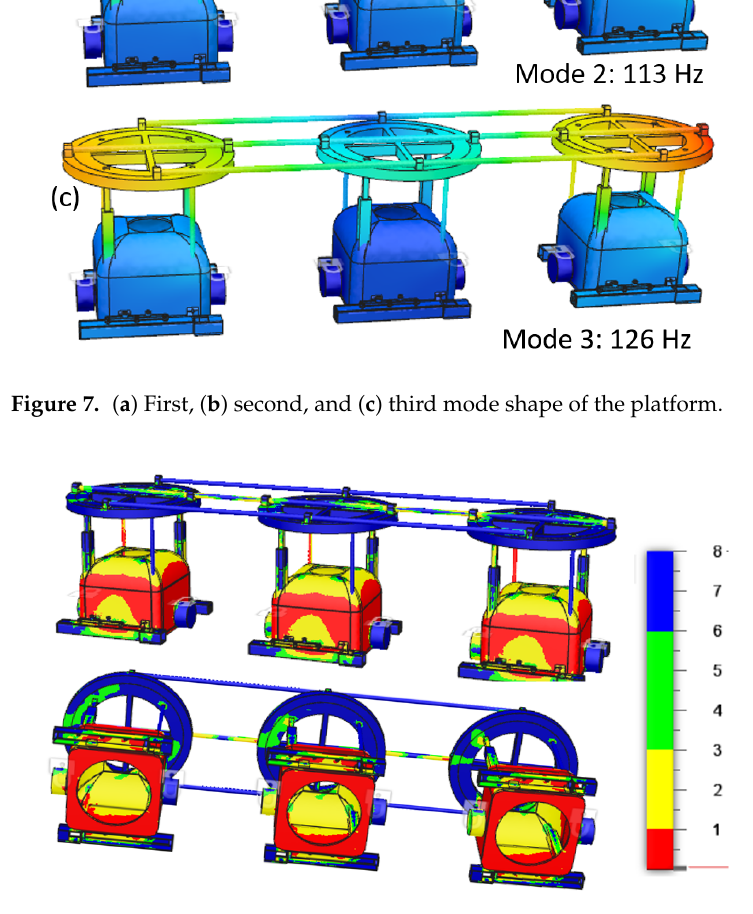
Figure 8. Factor of safety of the